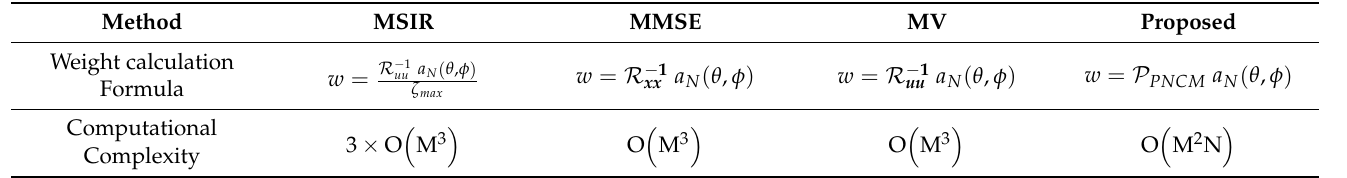
Table 1. Comparing the computational complexity of the proposed method with three rival techniques. Method MSIR MMSE MV Proposed Weight calculation